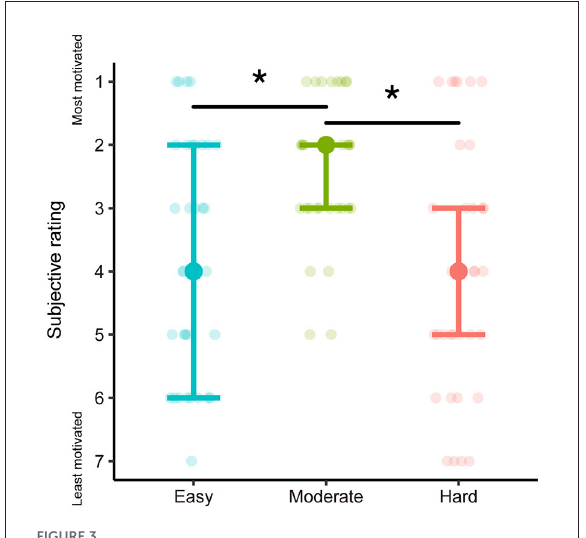
FIGURE3 Results of subjective ratings for each level of goal score. Filled dots and error bars indicate median and interquartile range, respectively. The transparent dots are the values for each participant. * p < Bonferroni-corrected α